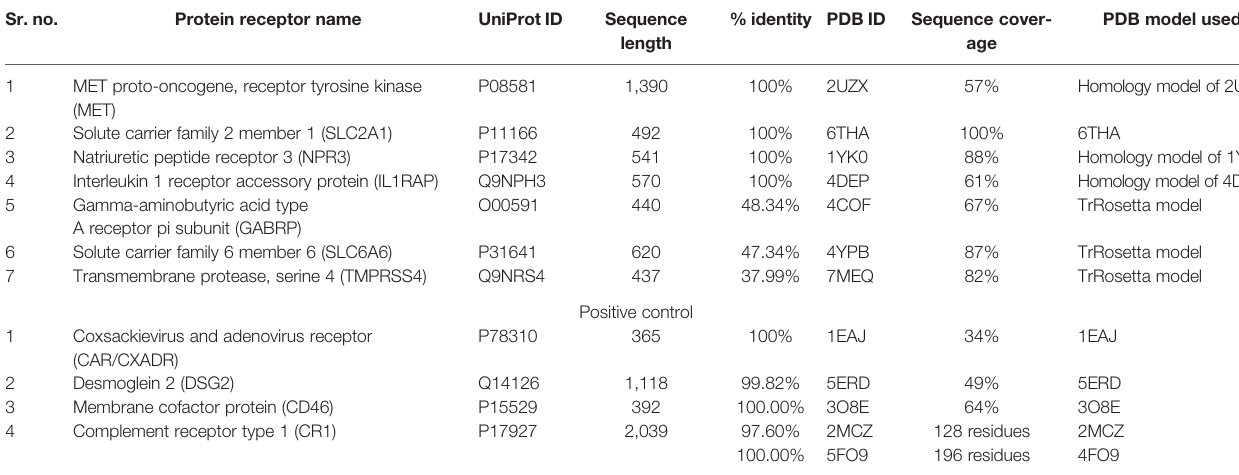
TABLE 1 | Pancreatic cancer